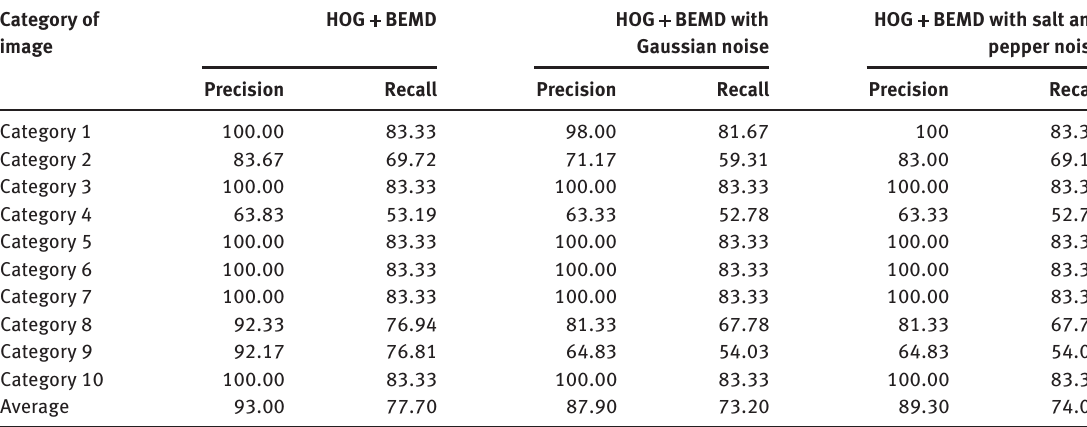
Table 3: Precision and Recall Values with Addition of